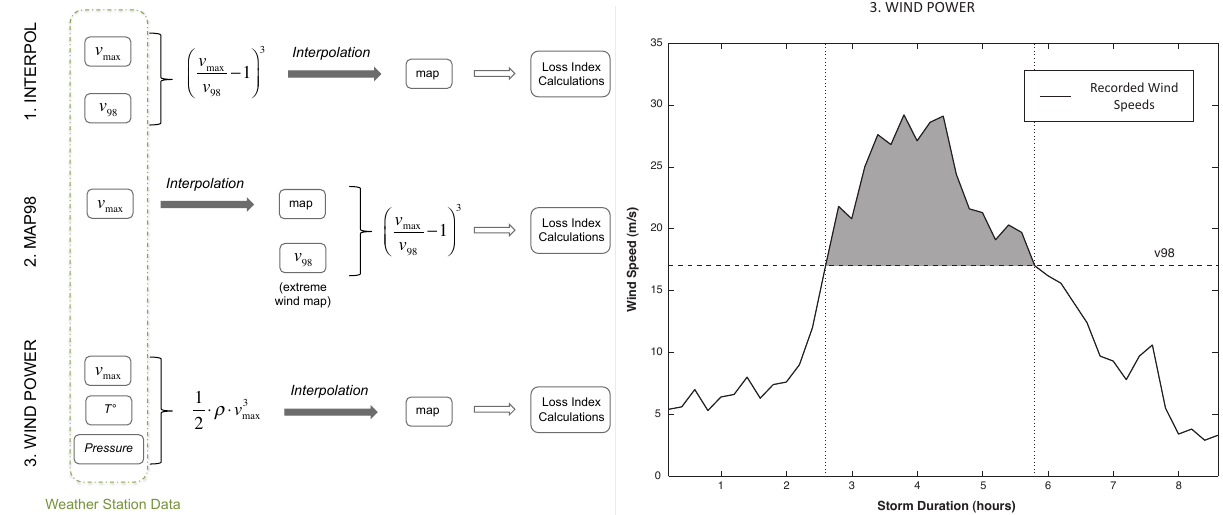
Fig. 2. Left: schematic diagrams describing the main steps of the 3 methods. The top describes the INTERPOL method, the middle the MAP98 and the bottom the WIND POWER. Right: illustration of how the relative wind power is assessed at a given weather station. Wind speeds recorded during a storm are plotted with the local v 98 value (17ms − 1 in the present example). During the storm, whenever the recorded wind speed exceeds the local v 98 threshold (here roughly between hours 2.5 and 6), the difference between the wind power corresponding to the recorded wind speed and to the v 98 value is calculated. These differences are integrated over the entire storm event in order to assess the relative wind power at a weather